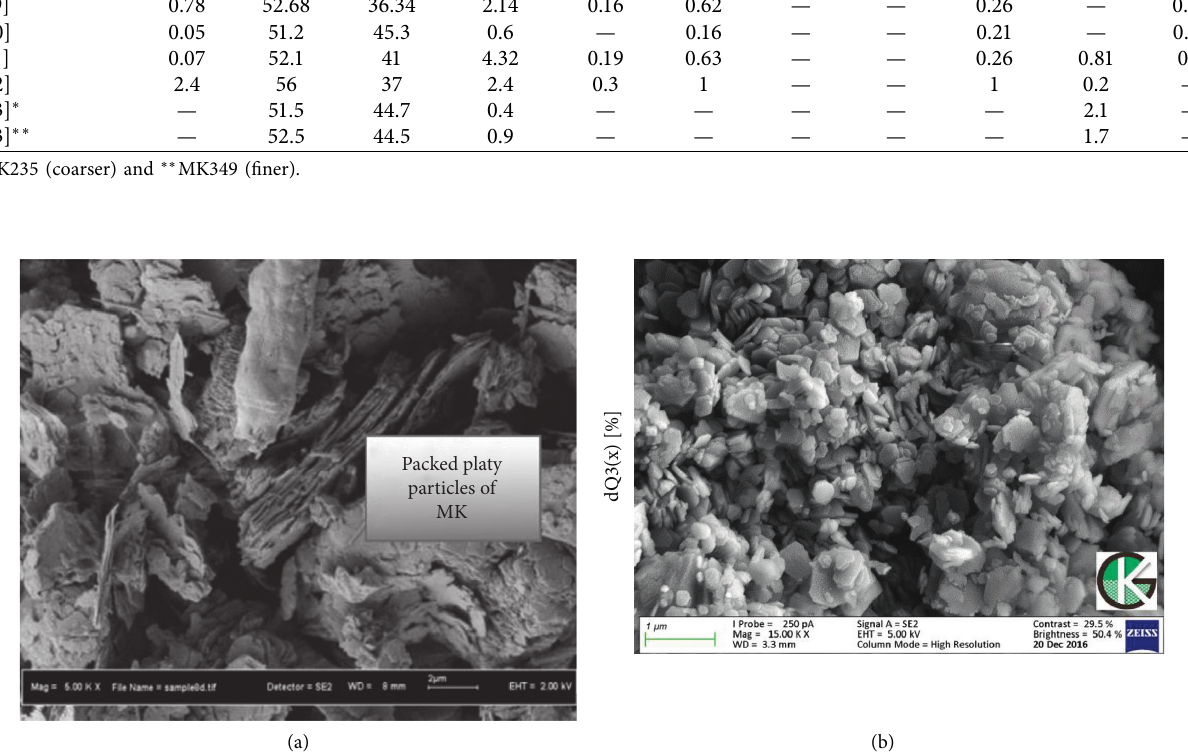
Figure 2: (a) SEM image depicting the shape and roughness of metakaolin particles [32] and (b) SEM particle image of K40 high-reactivity metakaolin